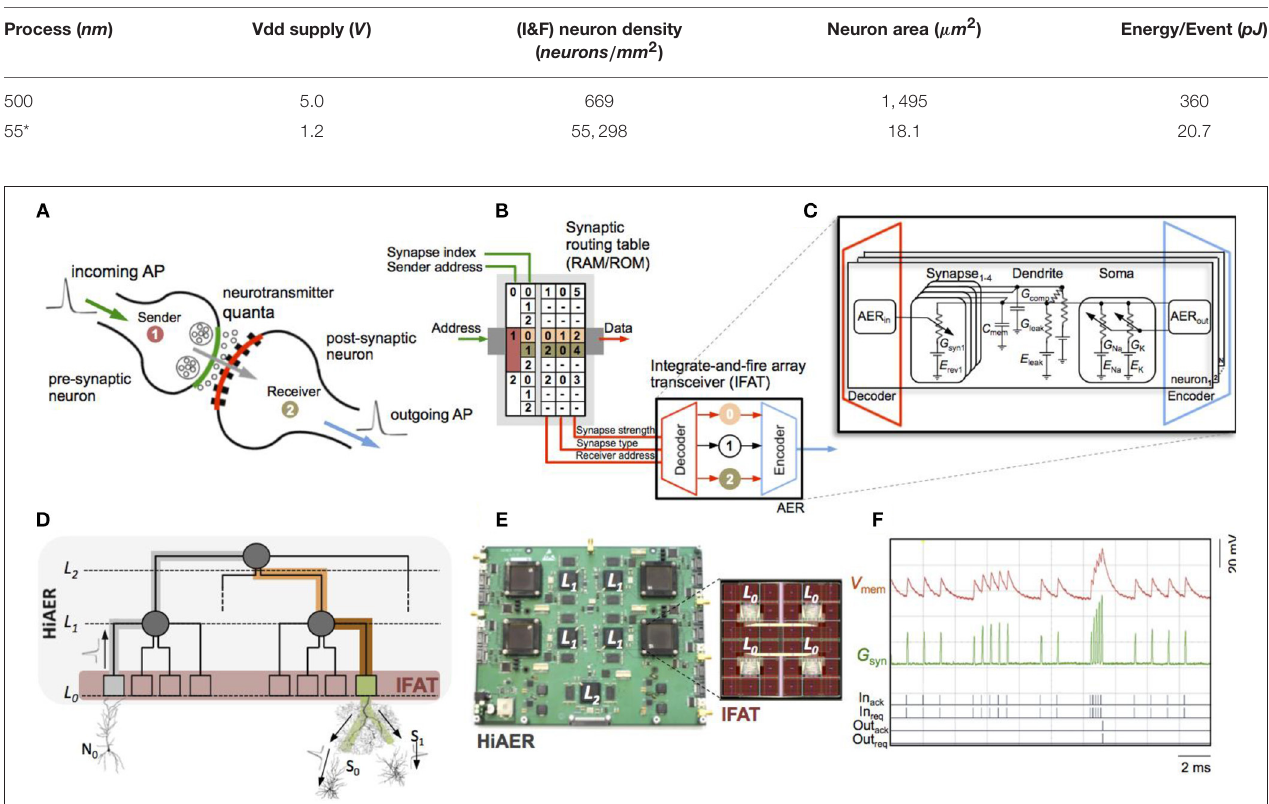
TABLE 3 | Measured ( * estimated) chip results.